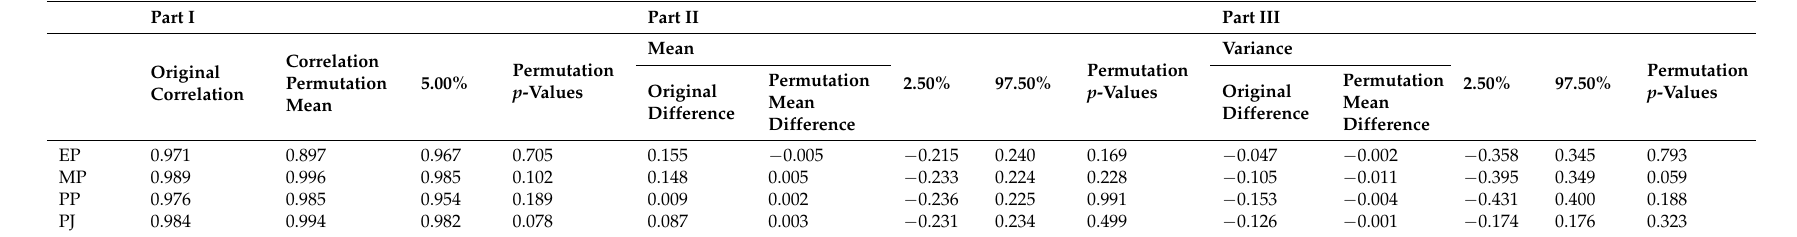
Table 7. Results of measurement invariance of composite models (MICOM) permutation test.